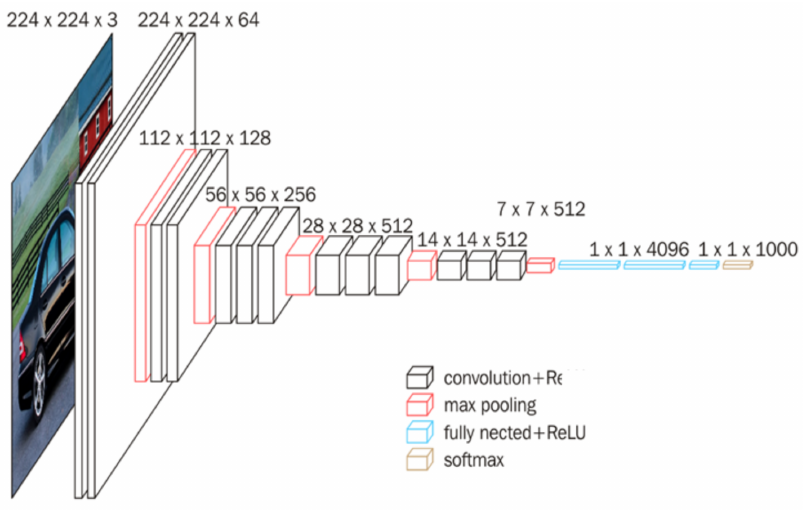
Figure 5. VGG16 network